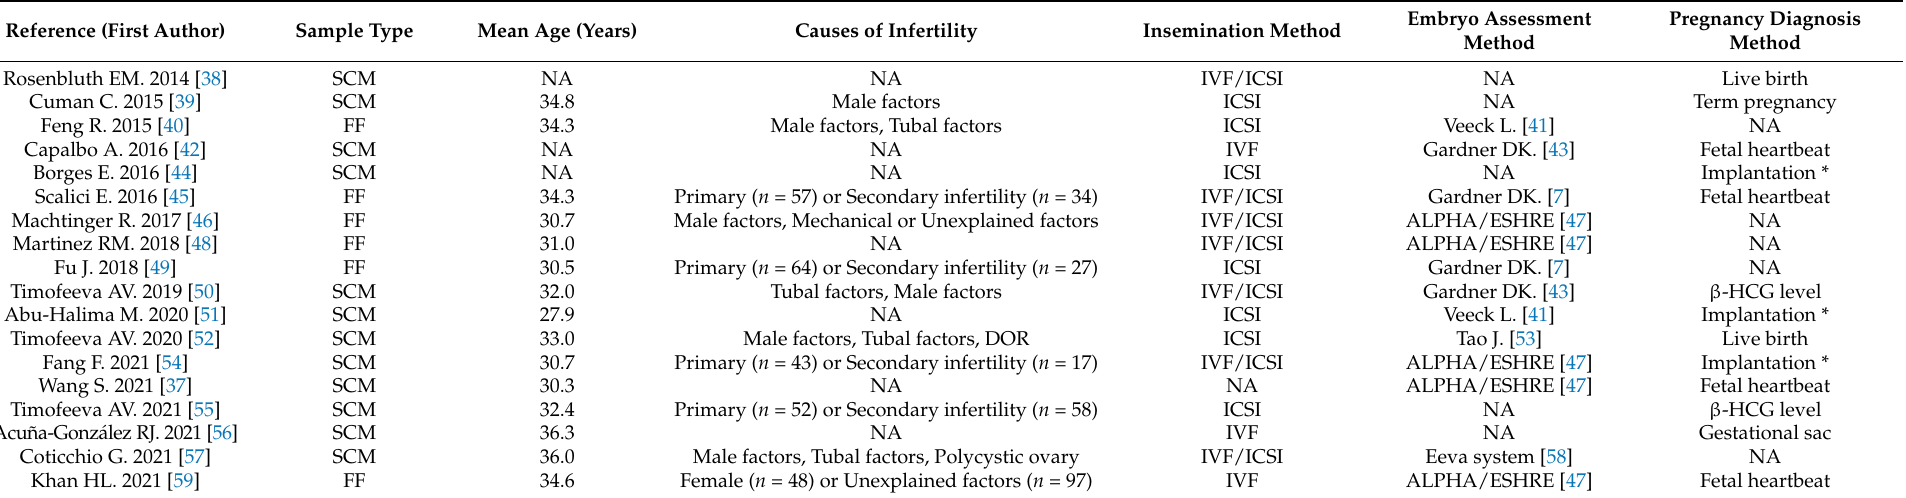
Table 1. Characteristics of reviewed